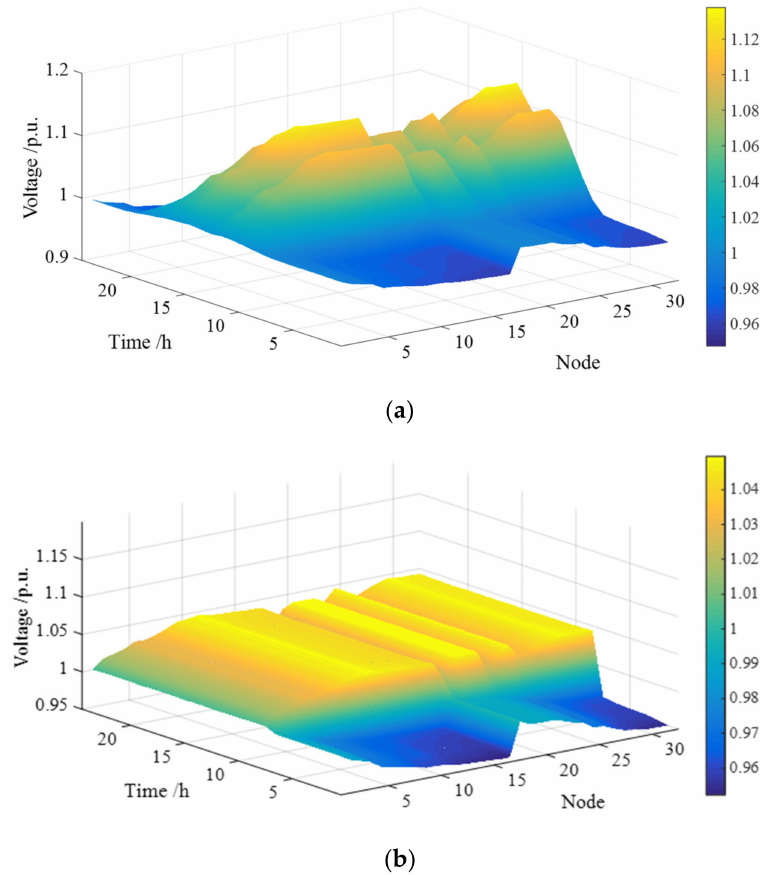
Figure 5. Node voltage distribution diagram without and with PV electricity curtailment. ( a ) Node voltage distribution diagram without PV electricity curtailment; ( b ) node voltage distribution diagram considering PV electricity